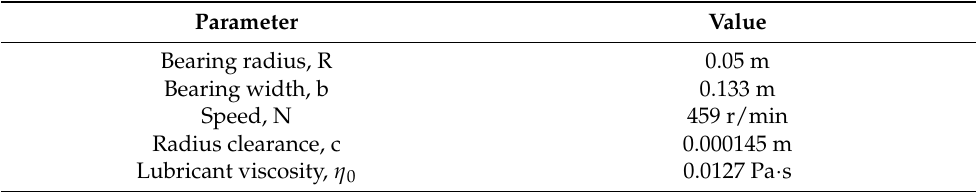
Table 2. Simulation parameters of journal bearing.